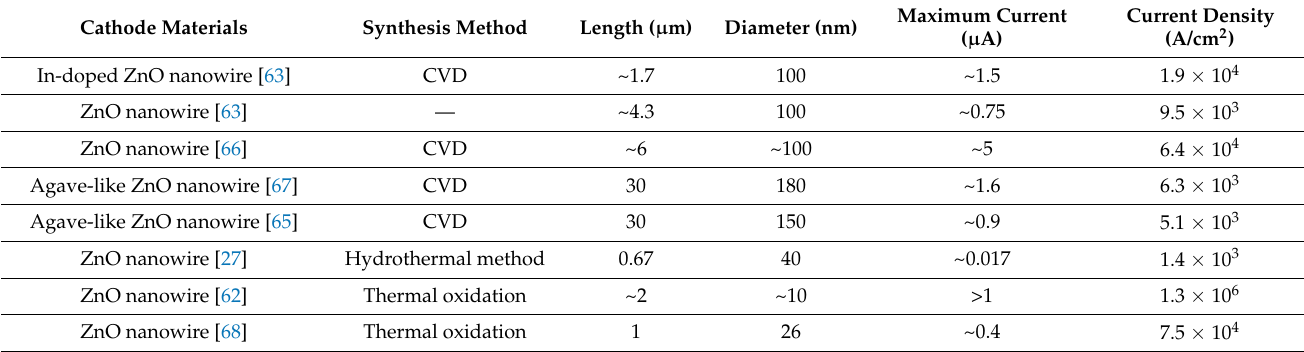
Table 2. Summary of field emission properties from individual ZnO nanowire. CVD is short for chemical vapor deposi- tion. Figure 10. Schematic diagrams of the setup for in situ field-emission measurement in a transmission electron microscope (TEM) ( a ) or SEM ( b ) system. ( a ) Reproduced from [63], with the permission of ACS Publications, 2007. ( b ) Reproduced from [65], with the permission of AIP Publishing, 2009.